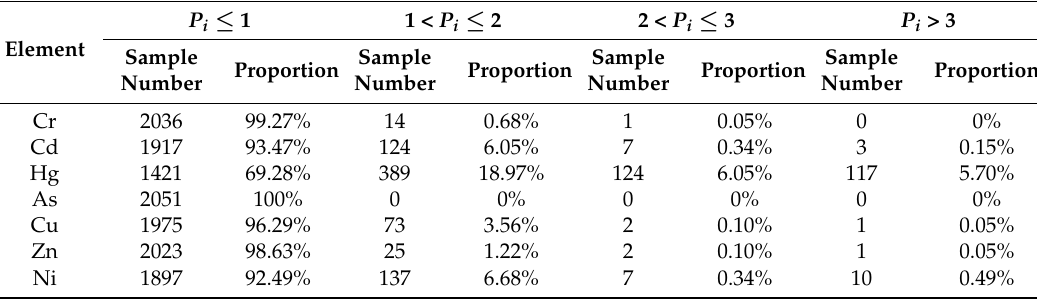
Table 5. Values of the SPI for different trace